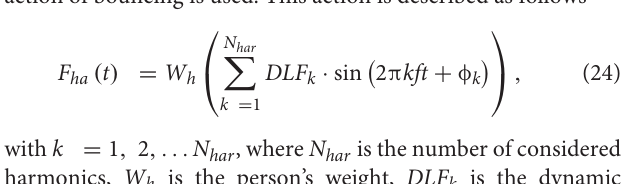
action of bouncing is used. This action is described as follows